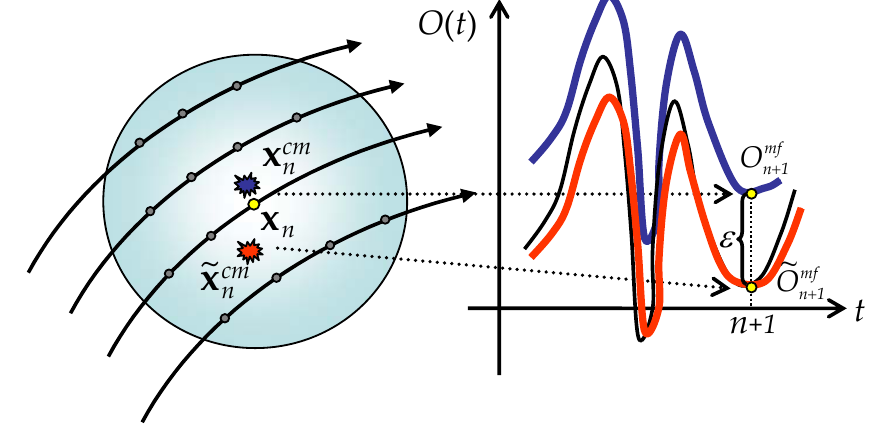
Fig. 2. Graphical representation of determining the embedding parameters of the observed time